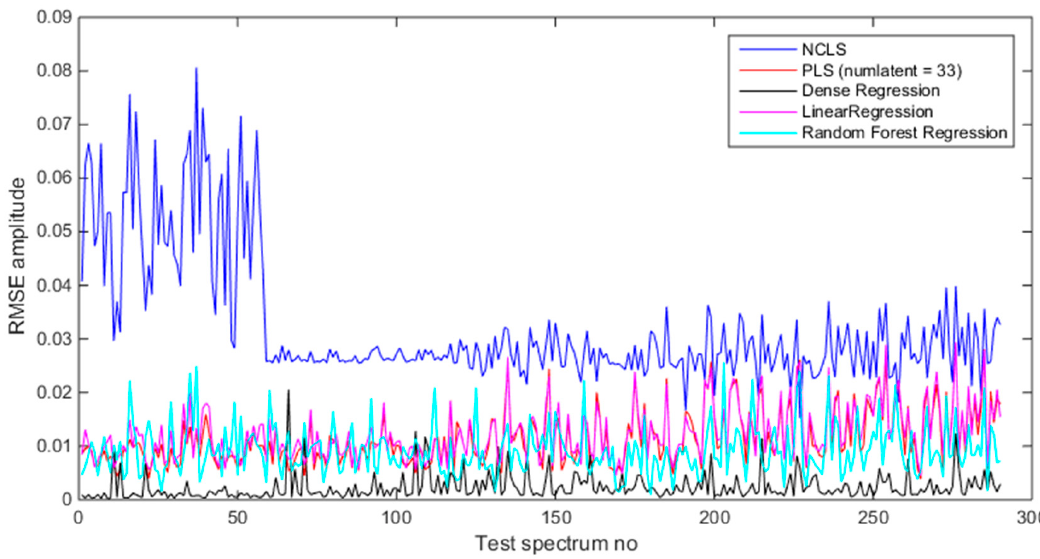
Figure 17. Mixing ratio estimation results when using foreground spectra (source + background).